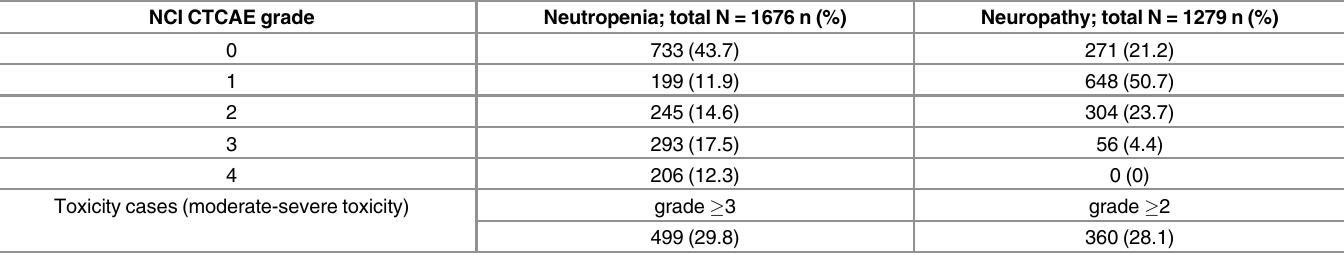
Table 2. Distribution of chemotherapy-induced neutropenia and taxane-related sensory neuropathy in the PGSNPS sample according to the National Cancer Institute Common Toxicity Criteria for Adverse Events (NCI CTCAE) version 2/3. NCI CTCAE